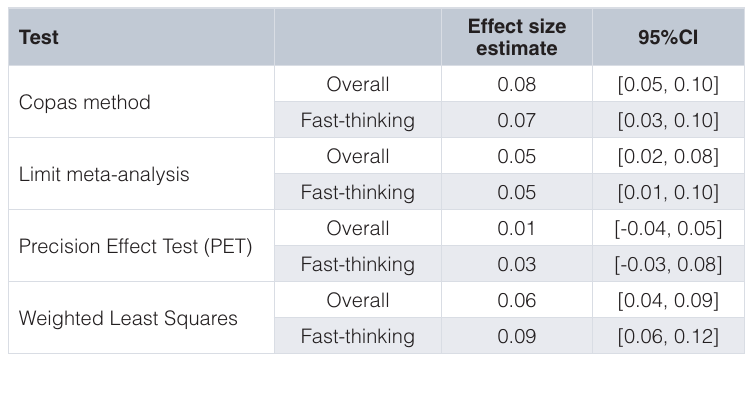
Table 3. Copas method, Limit meta-analysis, Precision Effect Test and Weighted least squares results for the overall and the “fast-thinking” database.